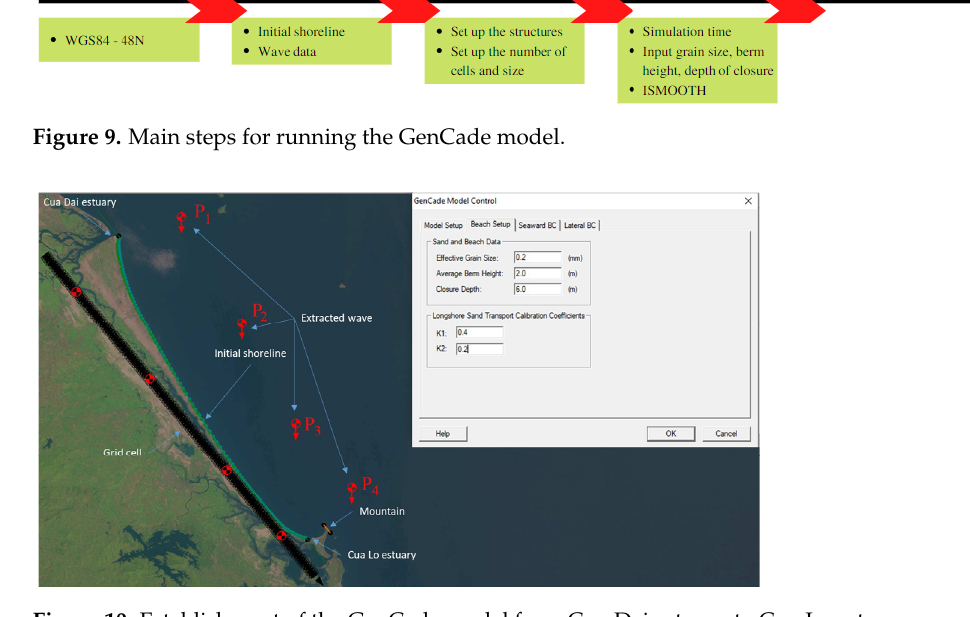
Figure 11. Performance of the one-line model based on two indices: MAE ( upper panel), RMSE ( lower panel) . The one-line model is validated by simulating the shoreline change for the period 2010–2015 and compared to the actual shoreline extracted from Landsat 8 image on March 2015. The model still performs well in predicting the accretion and erosion trends of the shoreline with the values of MAE and RMSE being 2.40 m and 3.41 m, respectively. There- fore, this well-calibrated and validated model with optimal couple of K 1 and K 2 will be adopted to evaluate the shoreline change along Quang Nam coast under the construction of two jetties. 3. Hydrodynamic and Morphological Changes in the Area of Cua Lo Estuary under the Natural Condition 3.1. Hydrodynamic and Morphological Changes under the Impacts of Monsoons The wave regime within the study area is mainly influenced by the propagation of deep-water waves into the coastal area and can be classified into two distinct monsoon seasons, i.e., winter monsoon (from October to March, the dominant wave direction is in